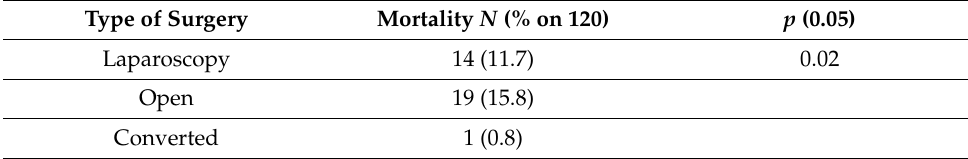
Table 7. Type of surgery (% on 120), mortality and p